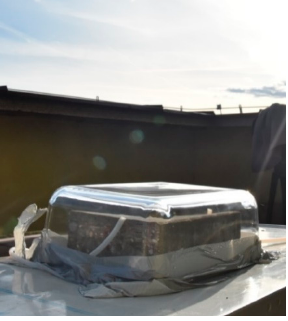
Figure 10. A novel test setup with a natural UV light source.